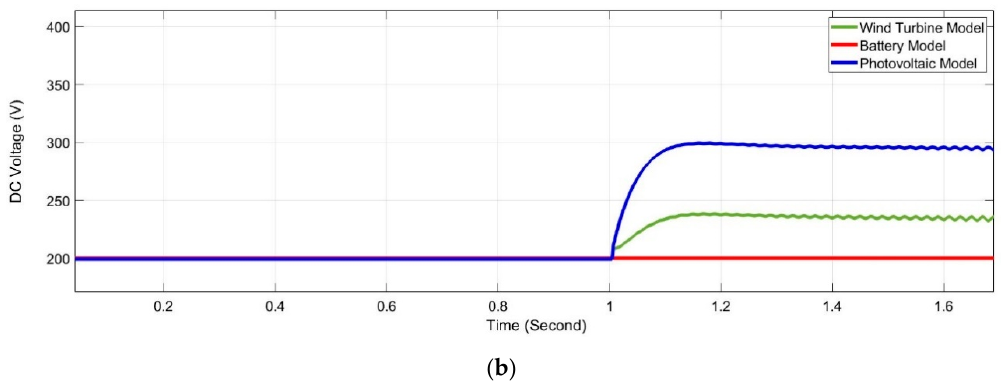
Figure 19. Simulation of loads change, where ( a ) active power responses, ( b ) responses of DC-link voltage.